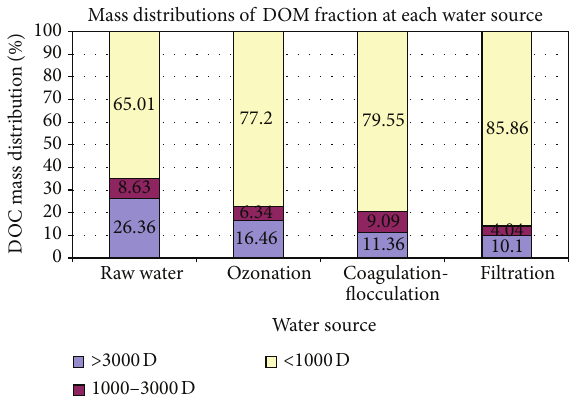
Figure 2: Fraction mass distribution of water treatment